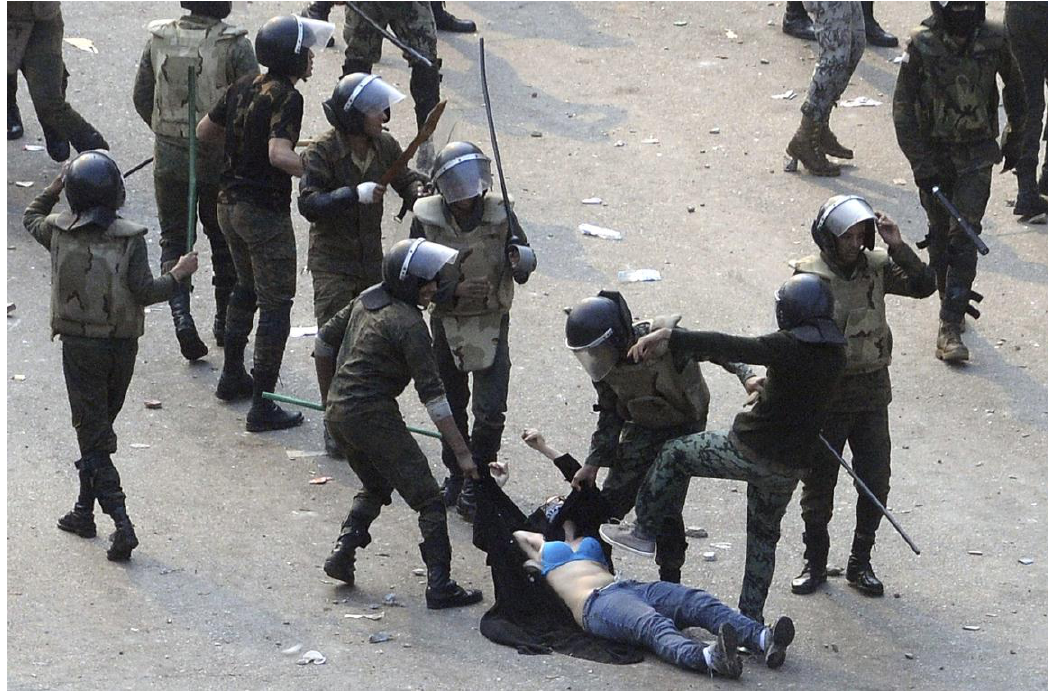
Figure 2. Egyptian army soldiers arrest a female protester during clashes at Tahrir Square in Cairo. 17 December 2011. Reuters/Stringer. Used with permission.